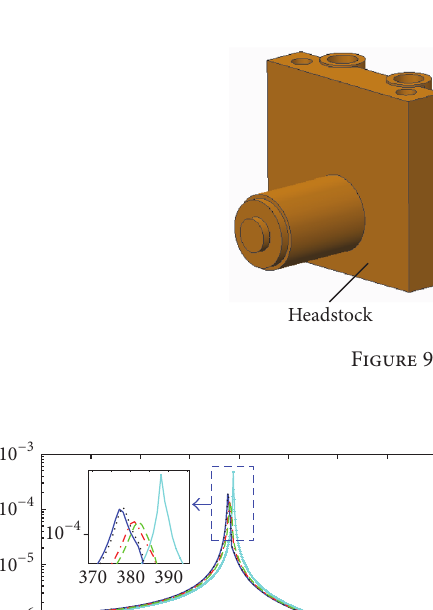
Figure 8: Modal shapes of the first three-order frequencies.